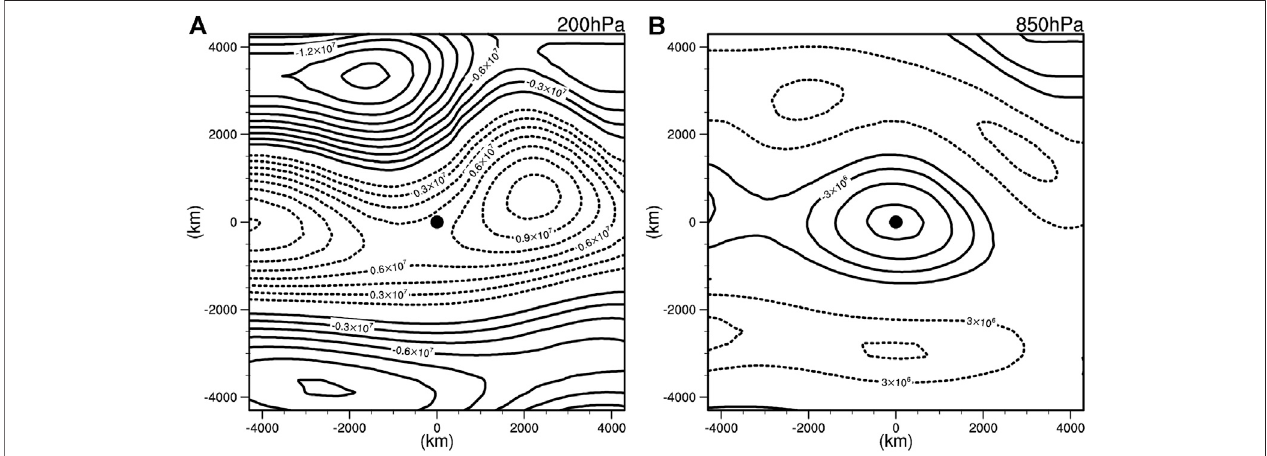
FIGURE3| Composite200 hPastreamfunction(m 2 s − 1 )at200 hPa (A) and850 hPa (B) withthewavenumbers4 – 7centeredatthecenterofMGsat850 hPa.The origin (0,0) is the center of MGs.